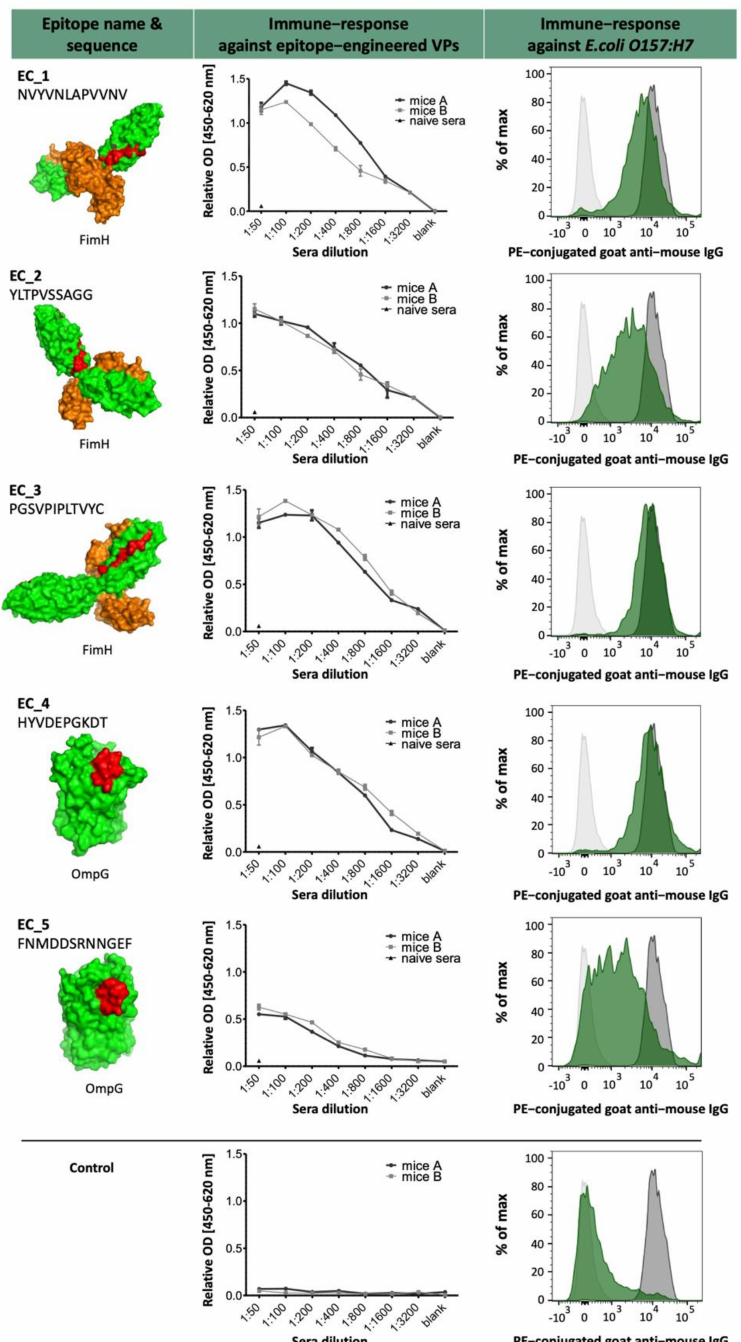
Figure 3. Overview of the five selected epitopes and their induced immune response. Five epitopes with their amino acid sequences and their location on the target protein (red) were shown using PyMOL. The crystal structure of the target proteins is received from the PDB database. The protein surface of the outer membrane porin G (PDB: 2iwv), as well as FimH together with FimC (orange) (PDB: 1QUN), is shown in green. The serum of the immunized mice was tested for epitope-engineered VPs in ELISA. The signals were detected with an anti-mouse coupled HRP antibody and measured at 488 nm. Furthermore, inactivated E. coli O157:H7 cells were stained with sera (1:100, green) and measured in flow cytometry. We used polyclonal PE-conjugated goat anti-mouse Ab for detection. A polyclonal rabbit anti- E. coli antibody (dark gray) served as a positive control. As a negative control (light gray), the cells were stained with the detection antibody